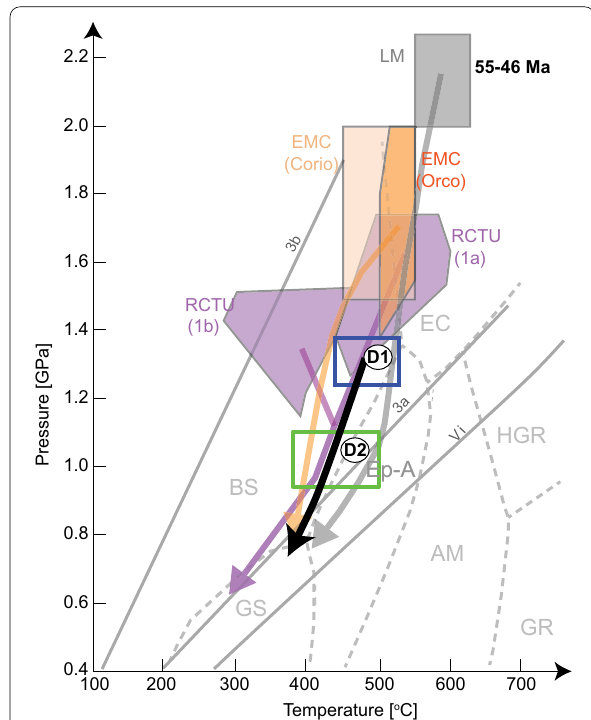
Fig. 15 P–T–d history of MZ rocks inferred from PT-estimates compared to P–T–d paths of other units close to the MZ: RCTU-Rocca Canavese Thrust Sheets Unit (Roda et al. 2018); EMC-Eclogitic Micaschists Complex, Corio (Rebay and Messiga 2007) and Orco (Pognante 1989b); LM-Lanzo Massif (Pelletier and Müntener 2006). The age of metamorphic peak conditions of the LM are after Rubatto et al. (2008). Metamorphic facies after Ernst and Liou (2008): GS: greenschist; Ep-A: epidote-bearing amphibolite; BS: blueschist; AM: amphibolite; EC: eclogite; HGR: high pressure granulite; GR: granulite. Geotherms: 3a) warm subduction zones, 3b) cold subduction